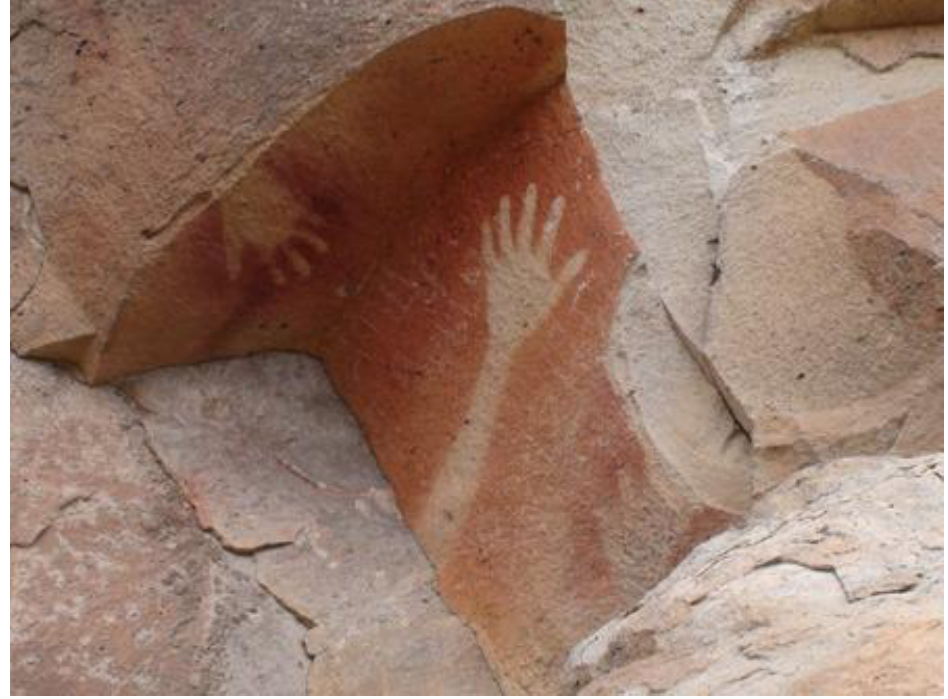
Figure 27. Self-declarative (“proprio”) hand-and-arm trace performative, Cueva de las Manos, Santa Cruz,